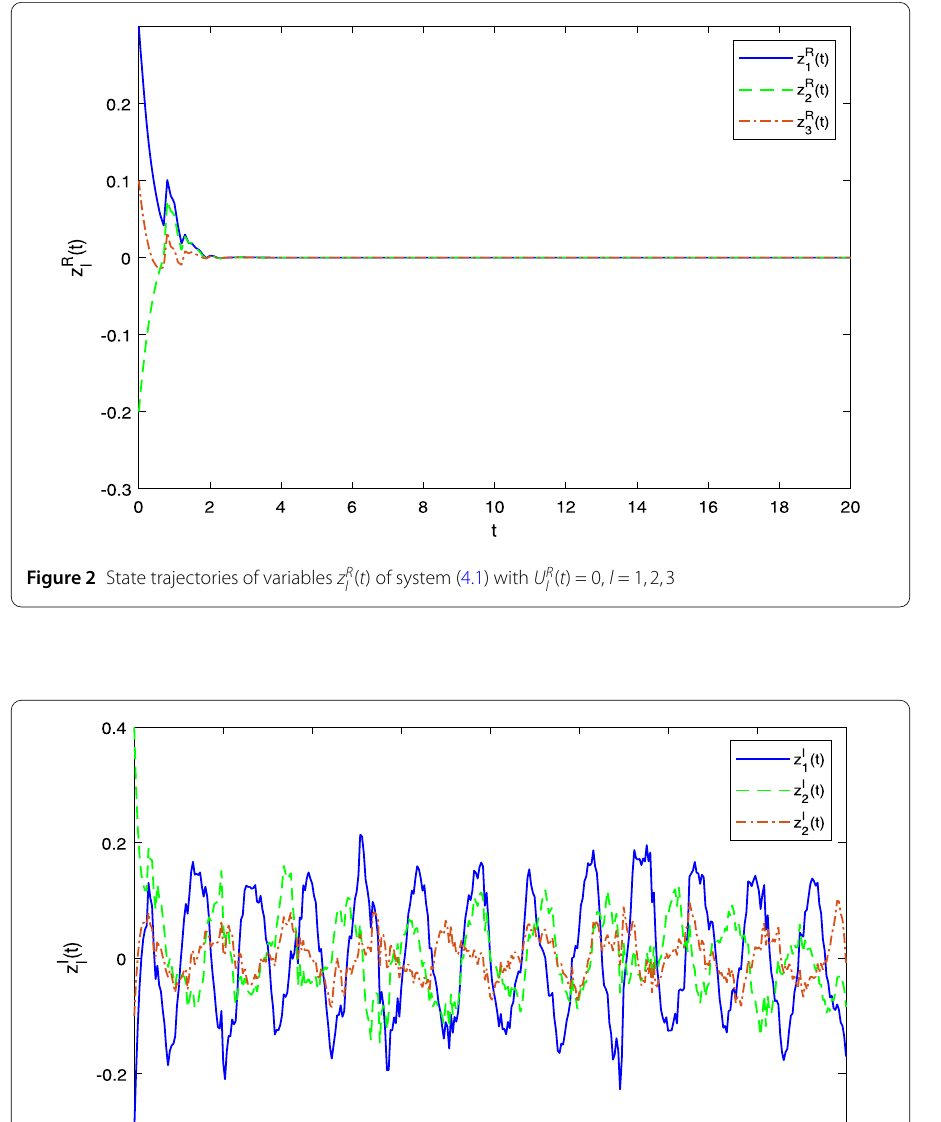
( t ) of system (4.1) with U I l